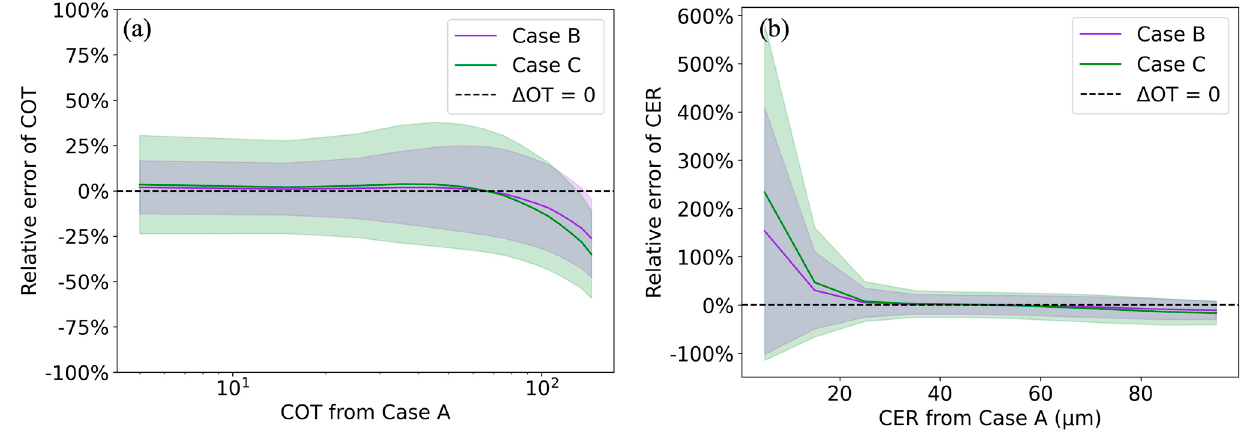
Figure 5. Relative errors of Case B and Case C as a function of ( a ) COT or ( b ) CER retrieved from pixel-averaging as in Case A. The shaded regions show ± 1 weighted standard